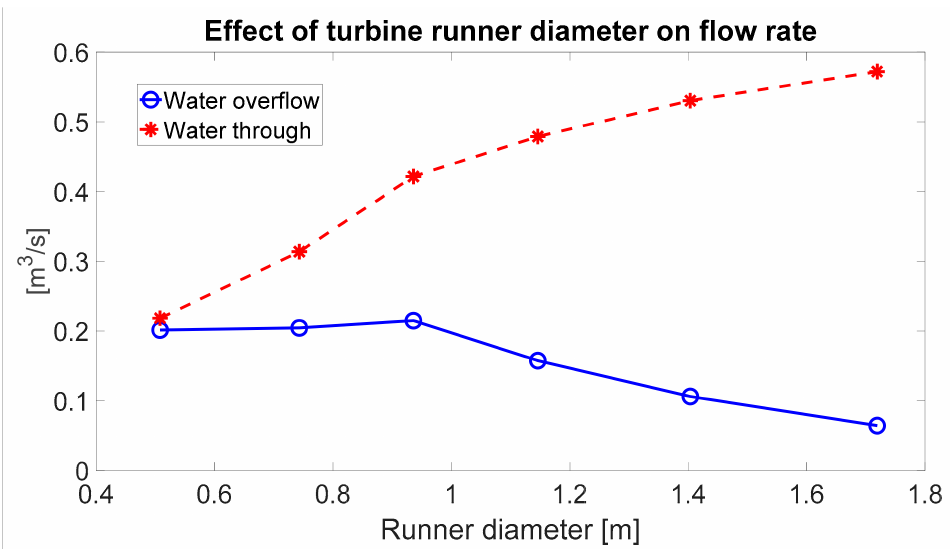
Figure 16. Water flow through turbine and water overflow, as a function of the turbine runner diameter, at optimal configuration.